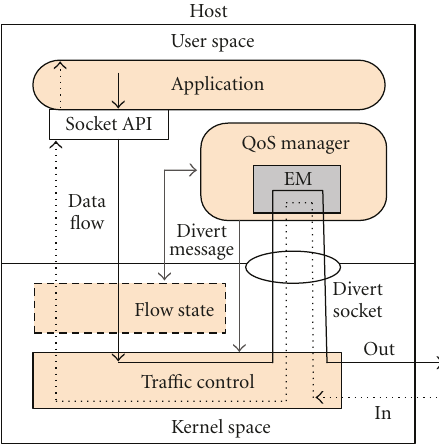
Figure 1: Basic components and operations of TQM host. Note that sender data flow is marked as “Out” (solid line) and receiver data flow is marked as “In” (dotted